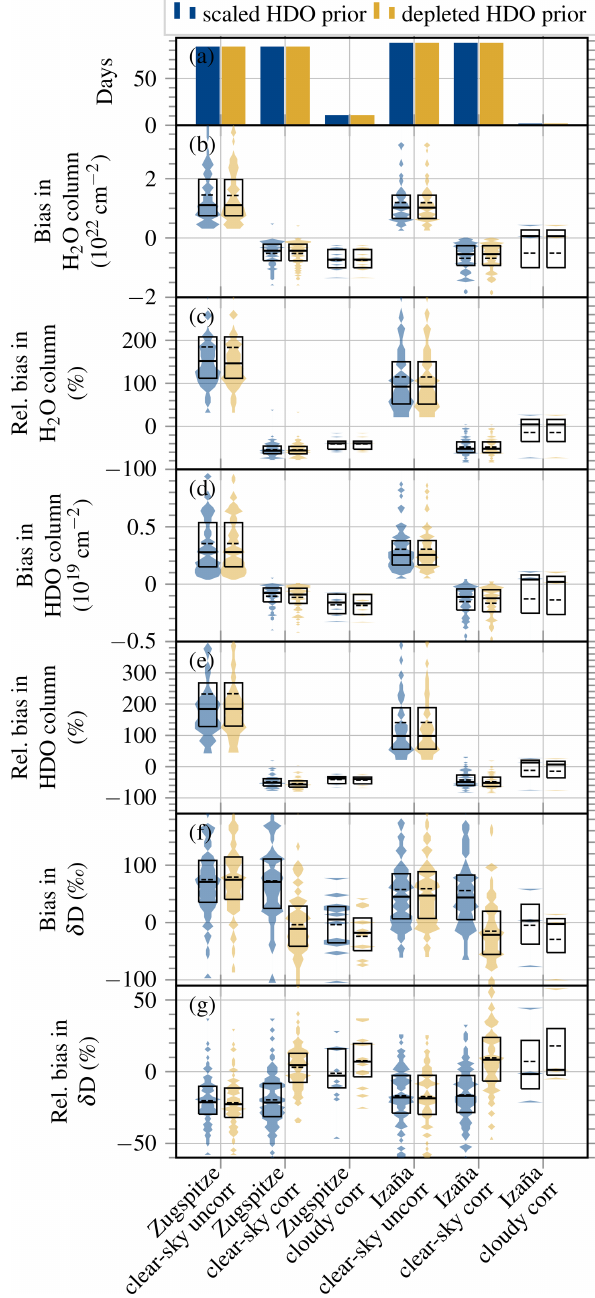
Figure 13. Biases for high-altitude TCCON stations plotted sim- ilarly to Fig. 9 but for retrievals with the standard scaled HDO a priori profile (blue) and an HDO a priori profile obtained by as- suming a more realistic δ D profile described in Sect. 2 (yellow). Shown are (a) the number of days with observations, (b) the bias in H 2 O columns, (c) the relative bias in H 2 O columns, (d) the bias in HDO columns, (e) the relative bias in HDO columns, (f) the bias in δ D, and (g) the relative bias in δ D. For each station, three entries are shown which correspond to uncorrected clear-sky observations, clear-sky observations corrected for the station altitude and altitude- corrected cloudy